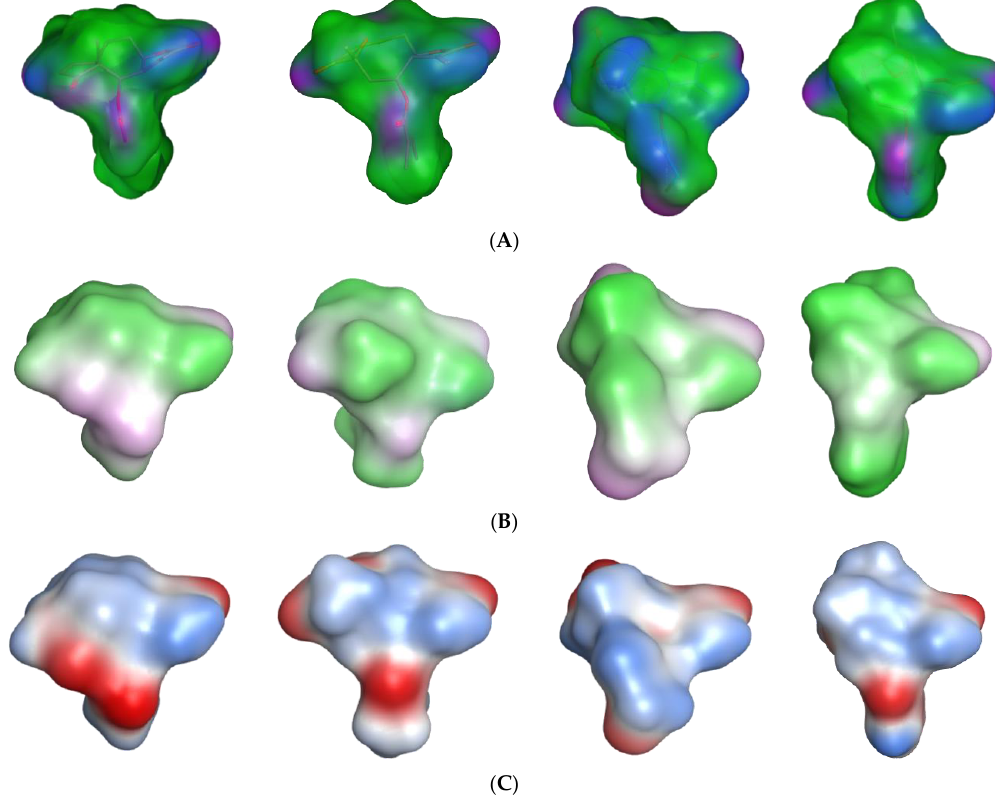
Figure 4. The molecular surfaces of 2 , 73 , 111 , and 97 (from left to right), the most active representative compounds of the different classes of STLs in the current series. Color schemes with regard to different properties are ( A ) active lone pair/hydrophobicity (pink: hydrogen bonding feature, green: hydrophobic, blue: polar), ( B ) lipophilicity (green: lipophilic, white: neutral, pink: hydrophilic), and ( C ) electrostatic potential (blue: positive, red: